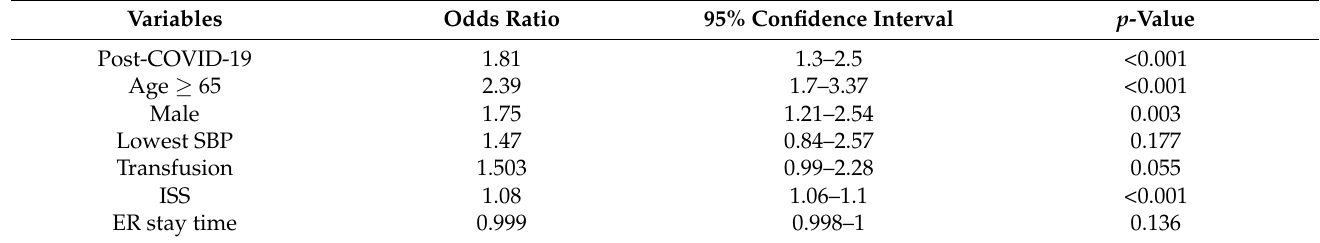
Table 4. Logistic regression analysis of the independent risk factors of